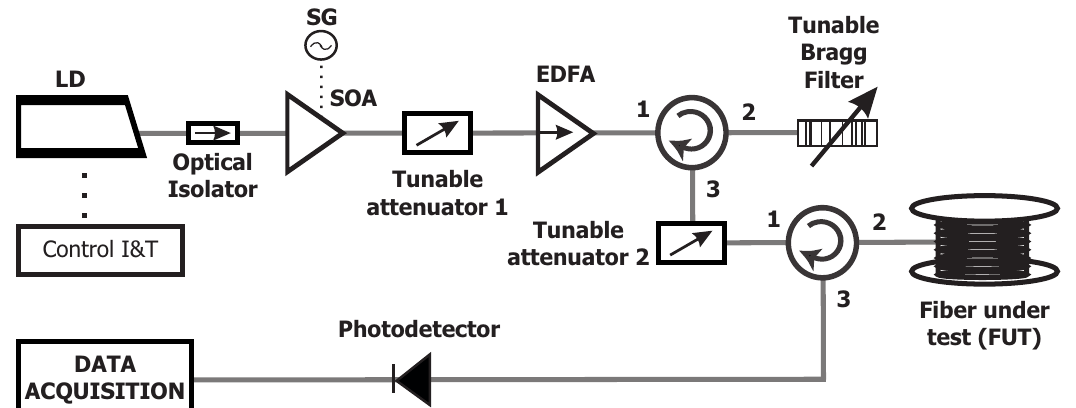
Figure 2. Architecture of the distributed acoustic sensing system FINDAS (phase-sensitive optical time domain reflectometry ( φ -OTDR)-based